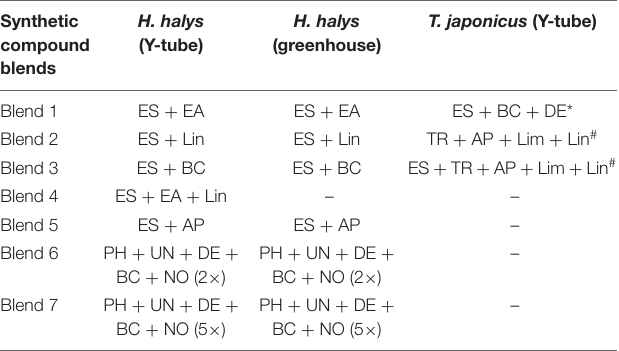
TABLE 2 | Blends of compounds used in the